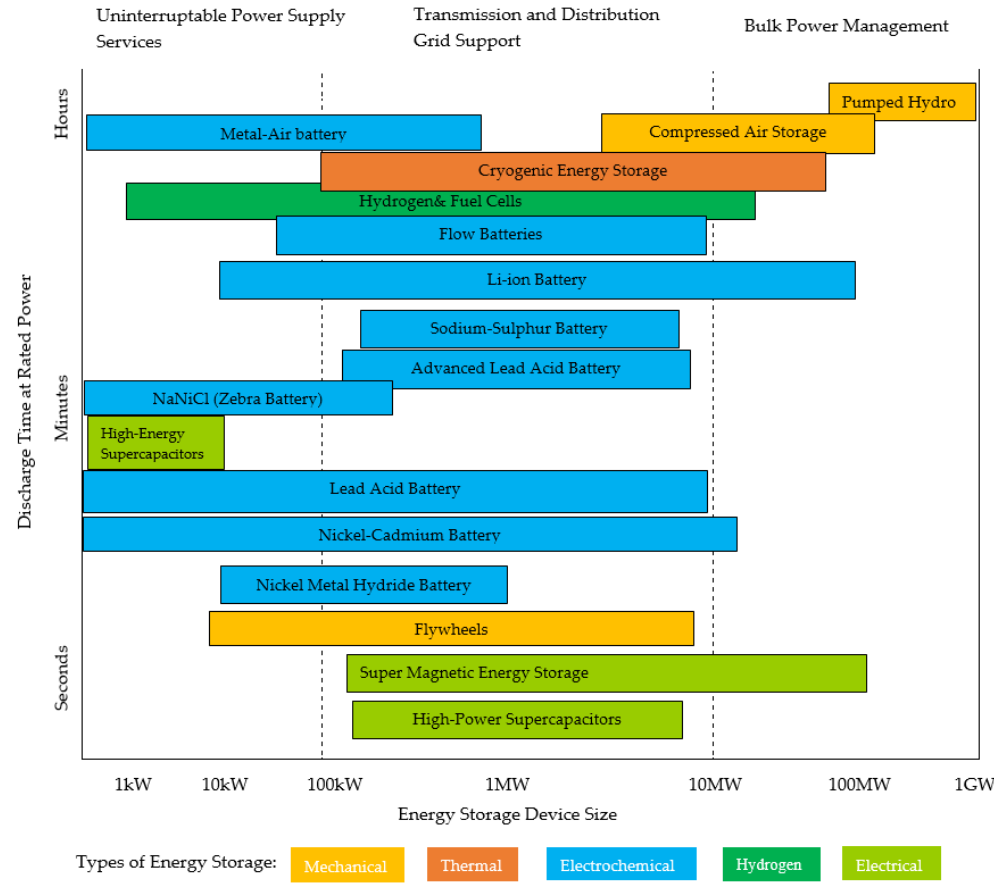
Figure 1. Classification of energy storage systems by the form of stored energy along with their power capacity, discharge time, and applications, adopted from